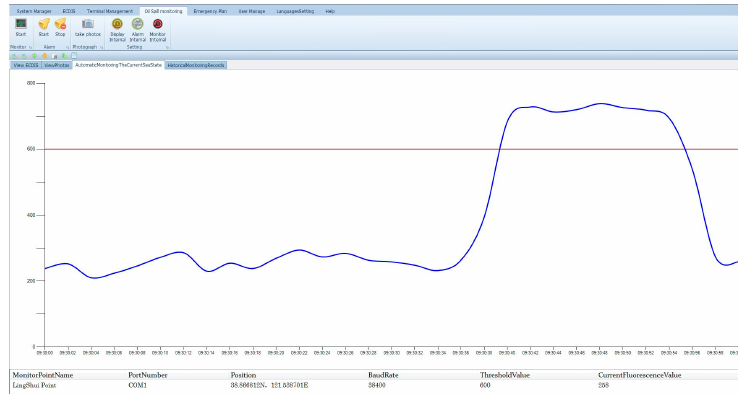
Figure 12. The monitor data in the continuous oil spill experiment.